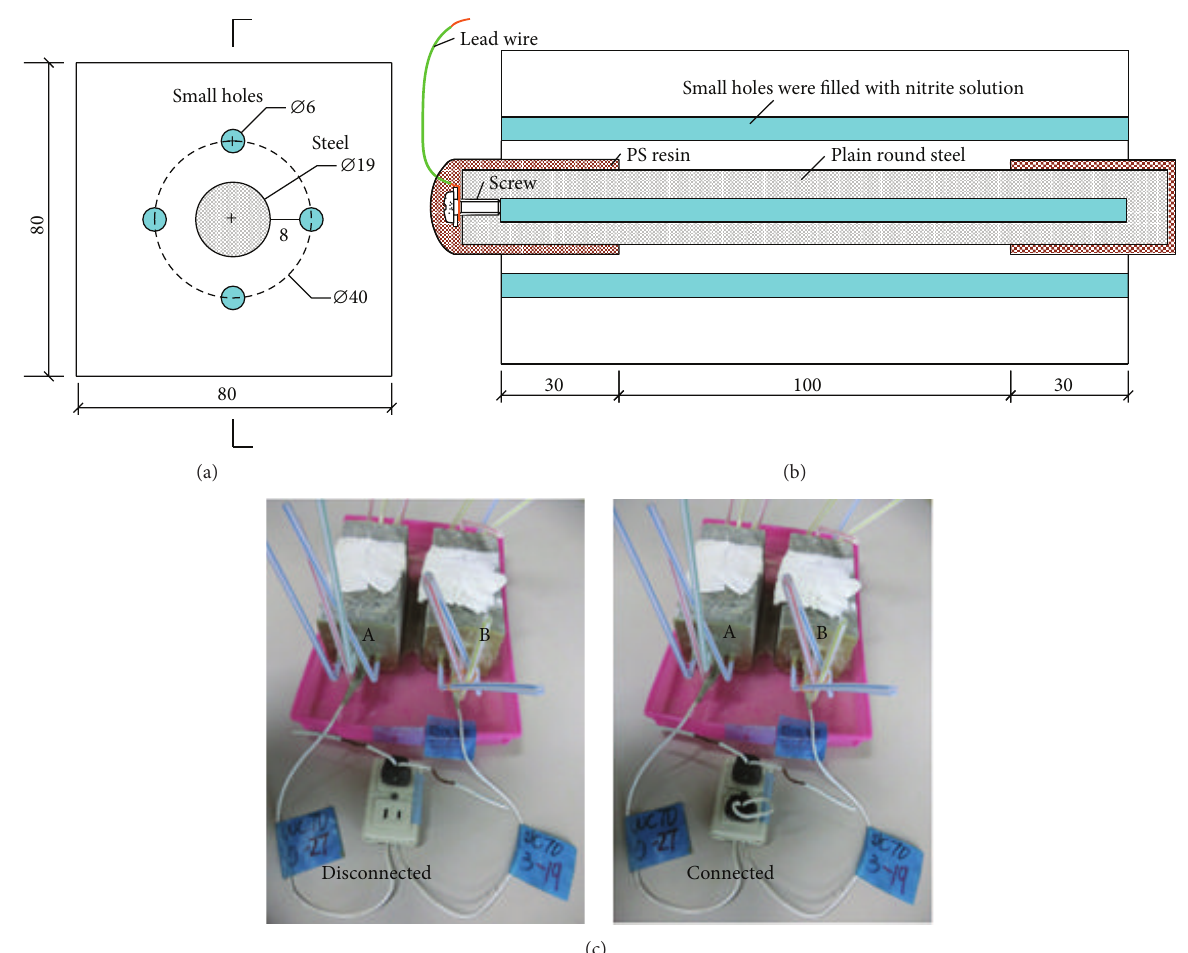
Figure 1: Specimens used in this study (unit: mm). (a) Cross section, (b) longitudinal section, and (c) actual specimens.